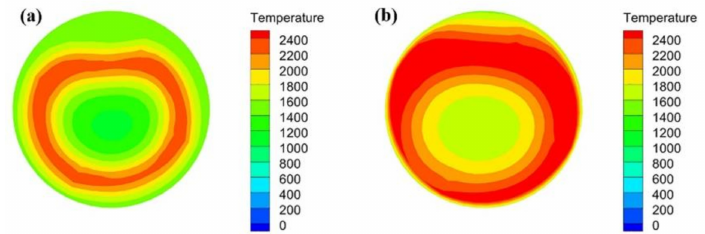
Figure 6. Temperature distribution on the cross sections A ( a ) and B ( b ) of the combustion